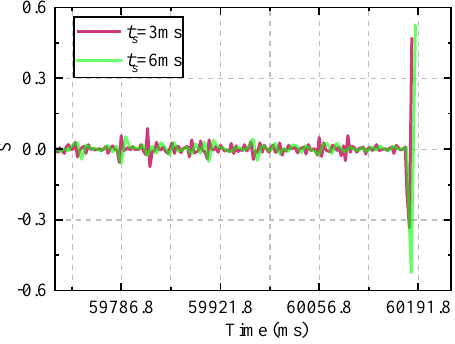
Figure 12. Plot of S with two different t s until fault detection.